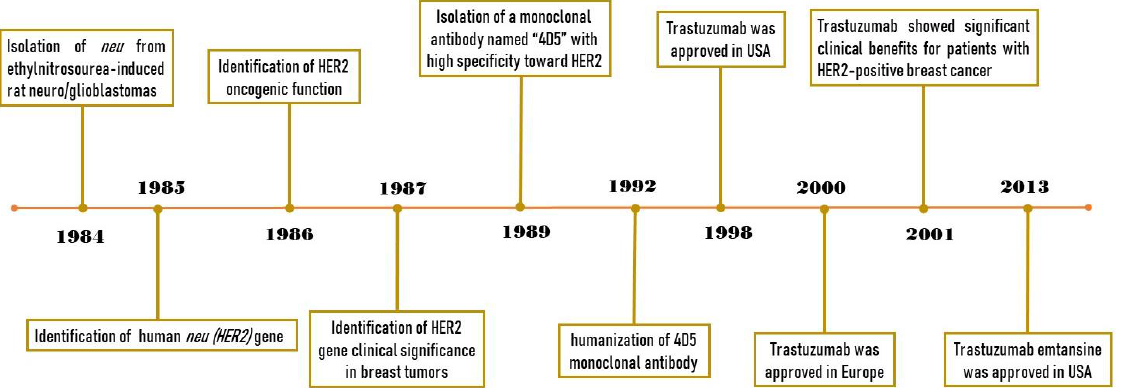
Figure 1. Timeline of trastuzumab history, from HER2 identification to demonstrating the clinical benefits of trastuzumab.